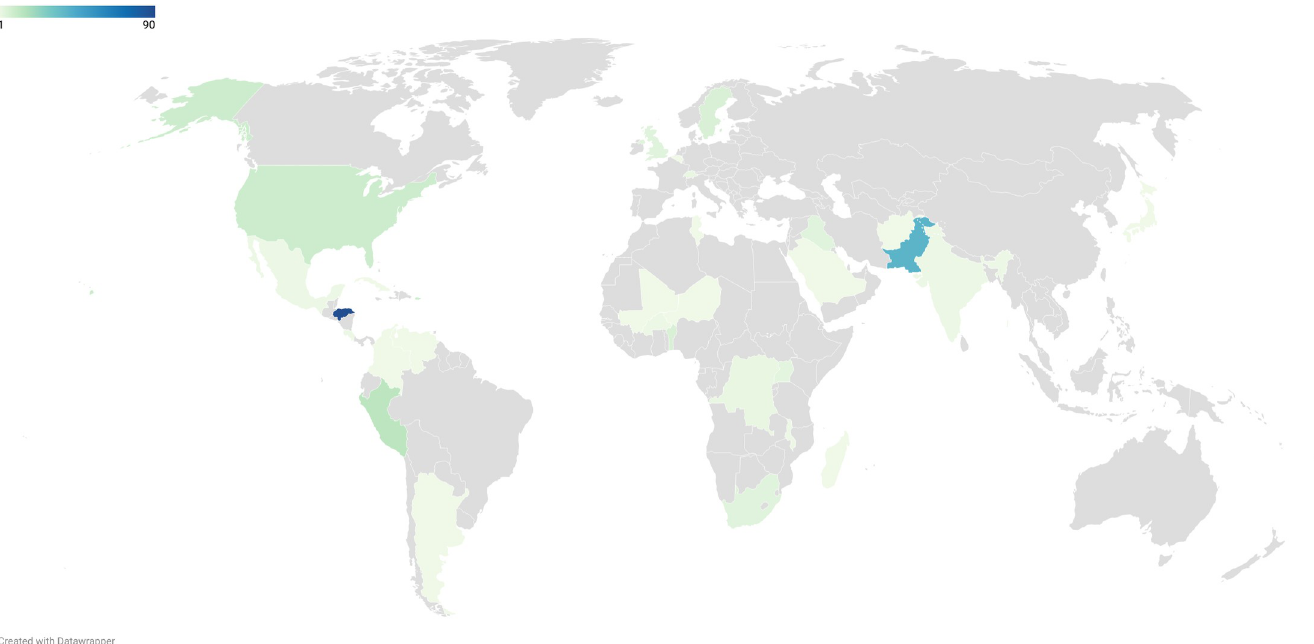
Fig 2. Geographical heat map showing the location of Questionnaire 1 respondents. Grey = no respondents based in this country. Light green = 1 respondent. Dark blue = 90 respondents. (The number of respondents corresponds to the shade of green or blue as shown within the spectrum of the color key).